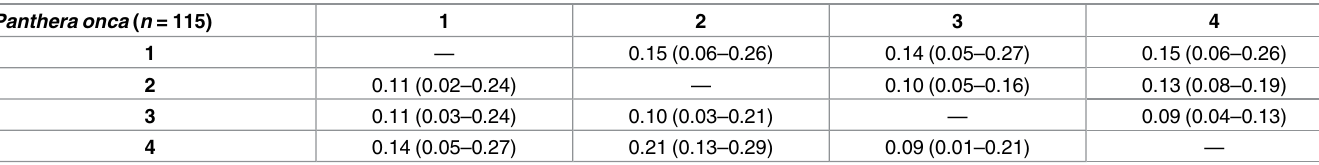
Pairwise F ST [58] and D est [59] estimates, with 95% confidence intervals (10,000 bootstraps) in brackets. Mesoamerican jaguar samples were grouped based on genetic clusters identified in STRUCTURE, version 2.3.4 [47] (1: cluster 1—Mexico, n = 7; 2: cluster 2—Guatemala and Belize, n = 65; 3: cluster 3 —Honduras, n = 7; 4: cluster 4—Costa Rica, n = 36). F ST estimates are above the diagonal, with pairwise D est estimates below the diagonal. n , number of